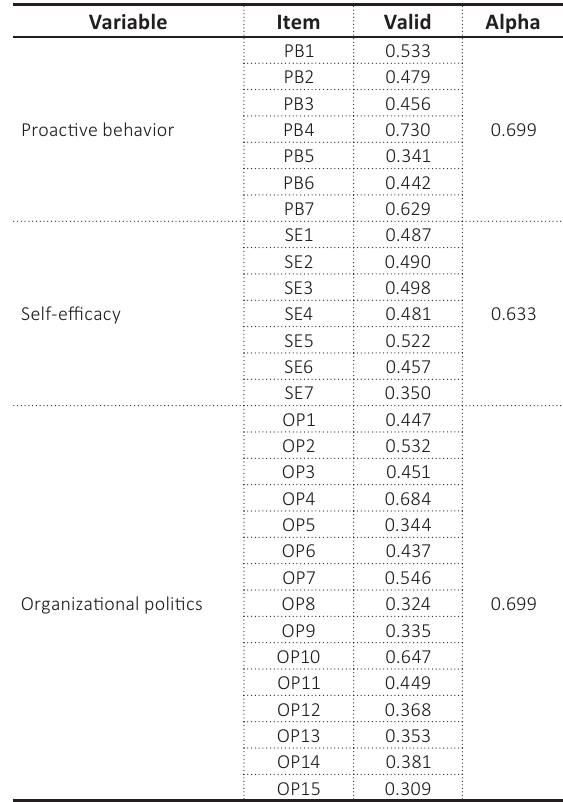
Table 1. Results of validity and reliability tests